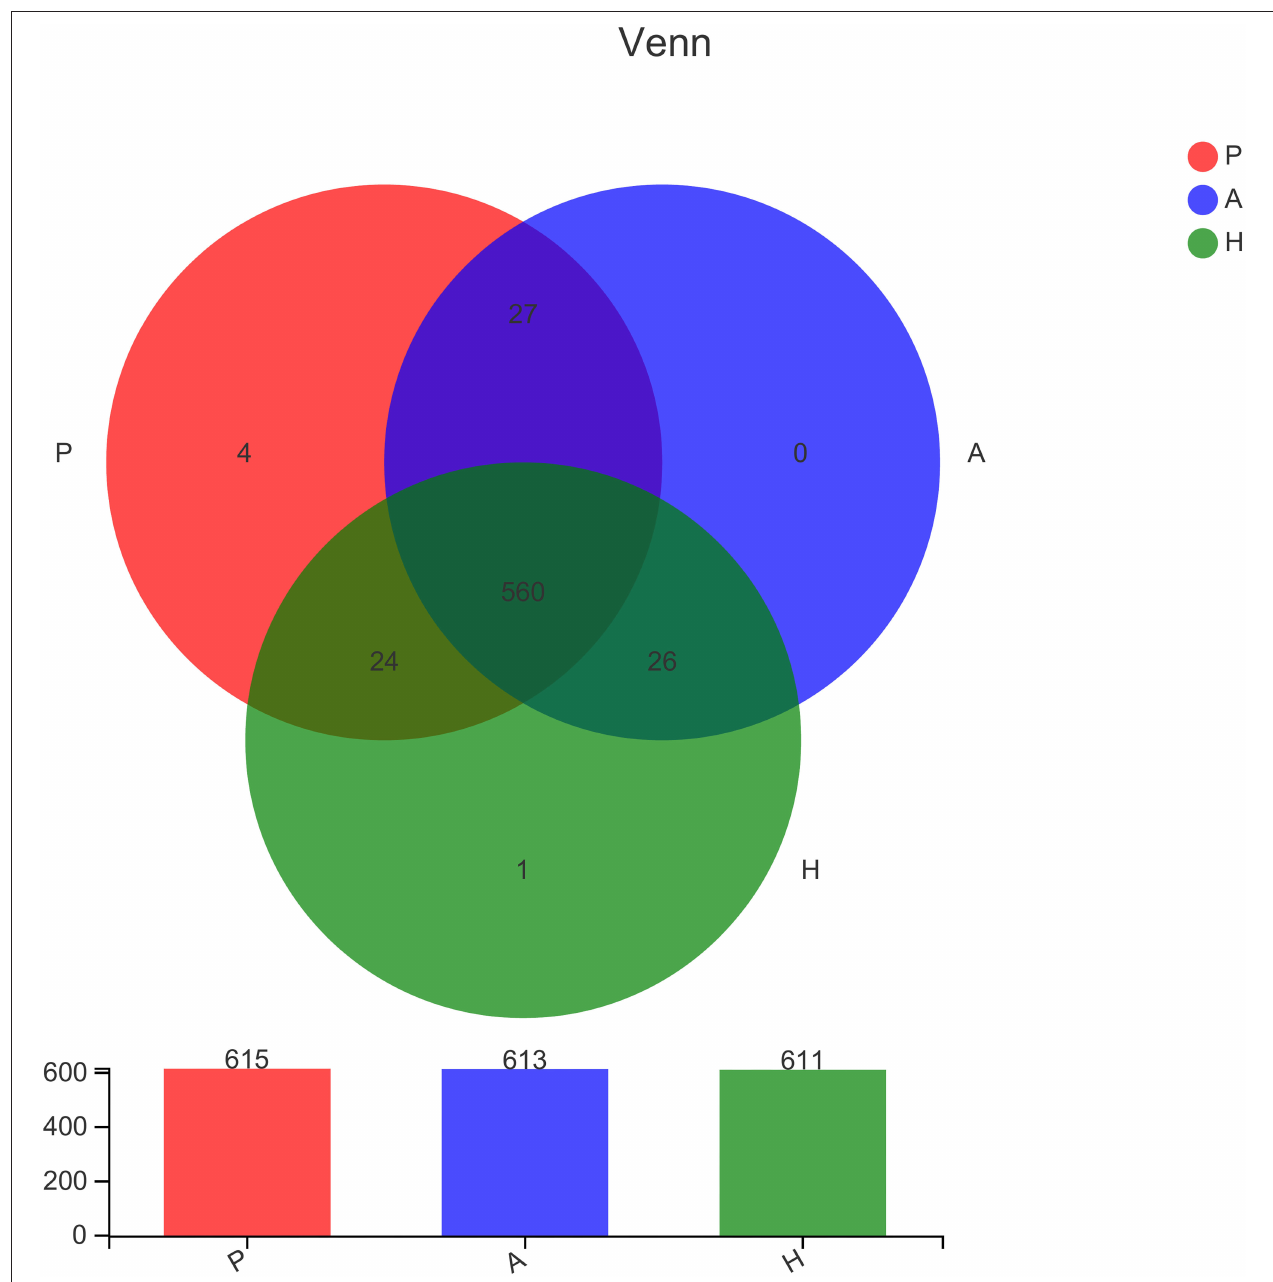
FIGURE 3 | Comparison of the type and number of operational taxonomic units. In the Venn diagram, rare microbial operational taxonomic units (OTUs) were removed without subsampling. There was a lot of overlap in the OTUs of each group. Group P, patients with Peutz–Jeghers syndrome (PJS); group A, asymptomatic relatives; group H, healthy